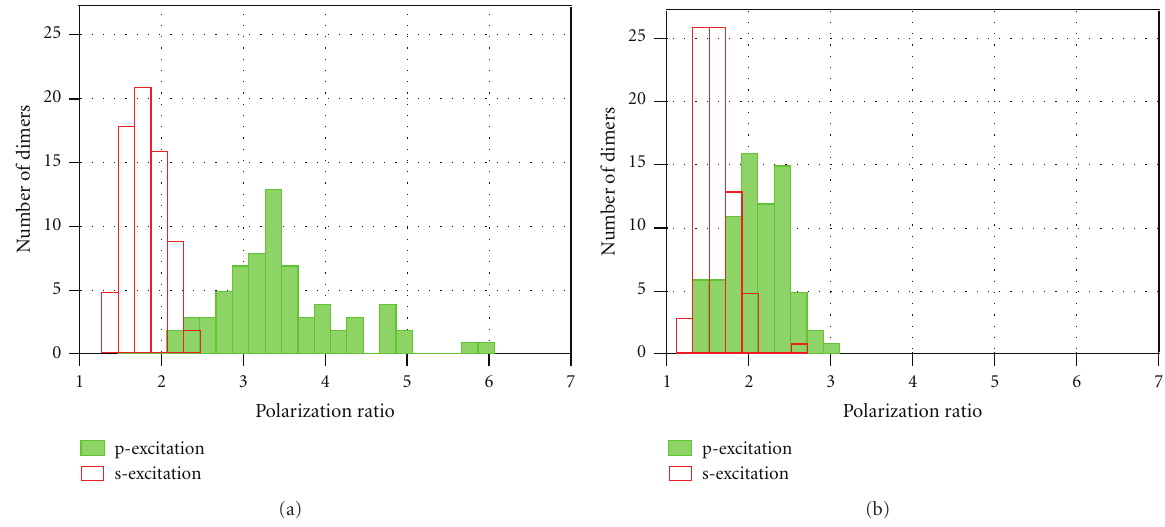
Figure 7: Distribution of the polarization ratio in detection (p-polarized over s-polarized luminescence) for about 60 dimers illuminated under p- or s-polarized light. (a) is for the dimers with 30 nm gap and (b) for the dimers with no